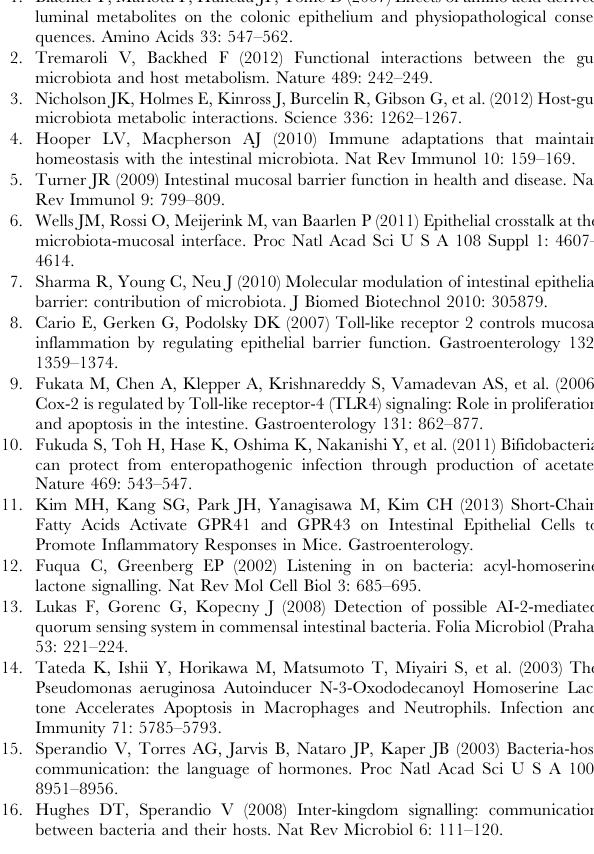
microcapsules (approximately 15 mg) by oral catheters. After 3 h, intestines were incised longitudinally. (TIF) Figure S3 The mRNA expression of TJ- and AJ-associated molecules in the small intestines of GF mice given indole- containing capsules. Real-time quantitative RT-PCR analysis of mRNA expression of Cldn7, Ocln, Tjp1, Ctnnb1, Cdh1 in the epithelium of small intestines in GF mice treated with MCT- containing capsules (n= 4) and indole-containing capsules (n= 4). The values were normalized to that of Gapdh . Data are representative of two independent experiments and show mean